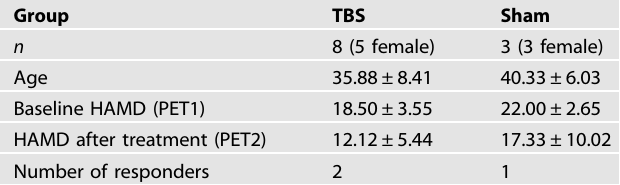
Table 1. Demographic information about the patients included in the study.